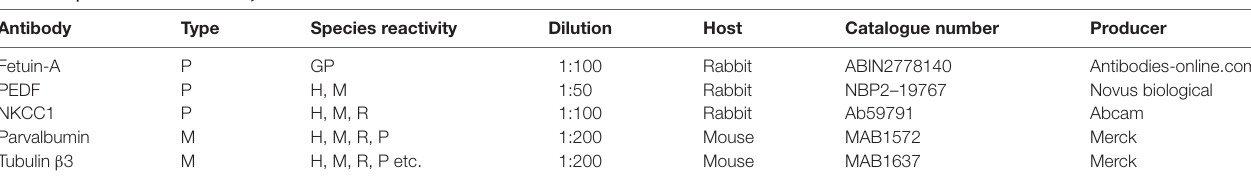
TABLE 1 | Immunohistochemistry